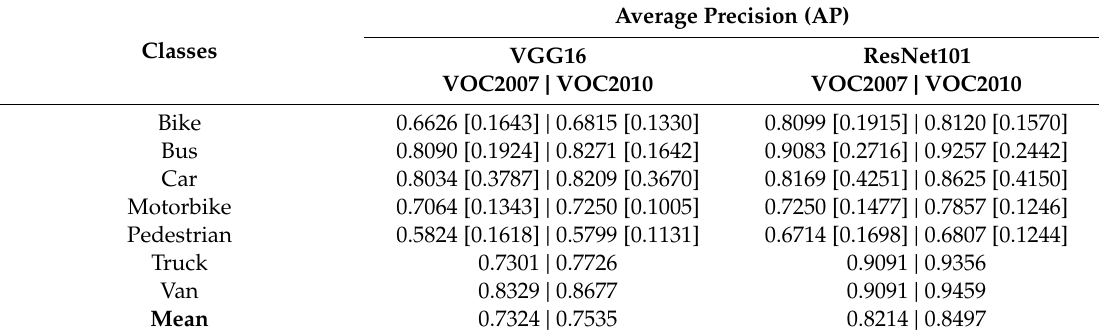
Table 2. Performance of our nighttime validation data obtained using models trained with our nighttime training data.